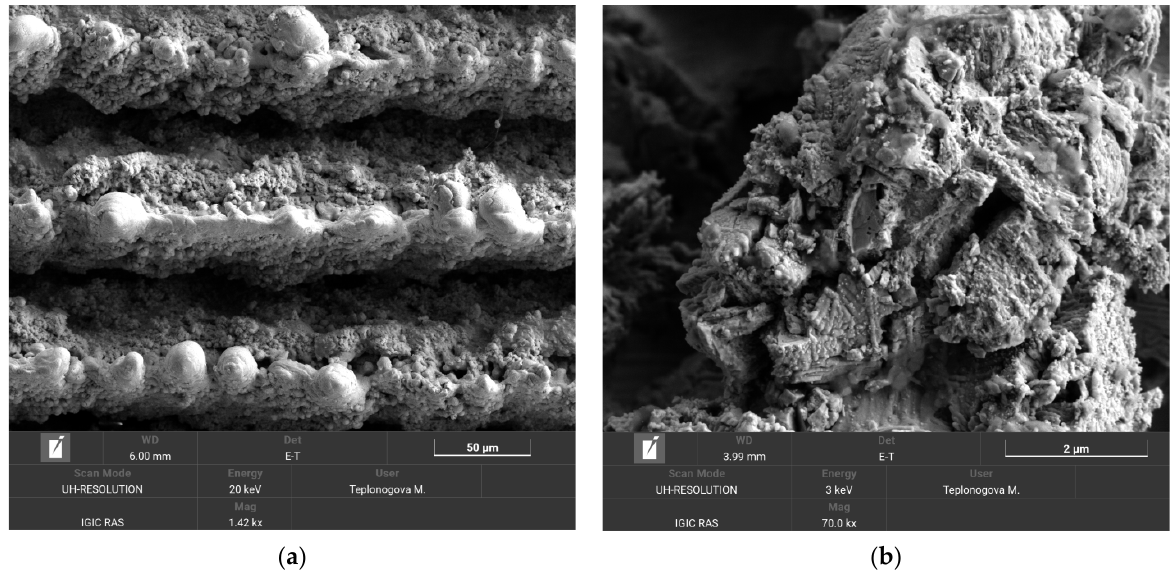
Figure 7. SEM images of the tungsten sample obtained by regime 13 taken after 10 cycles of the falling sand abrasion test. Scale bars: 50 μm ( a ) and 2 μm ( b ). falling sand abrasion test. Scale bars: 50 µ m ( a ) and 2 µ m ( b